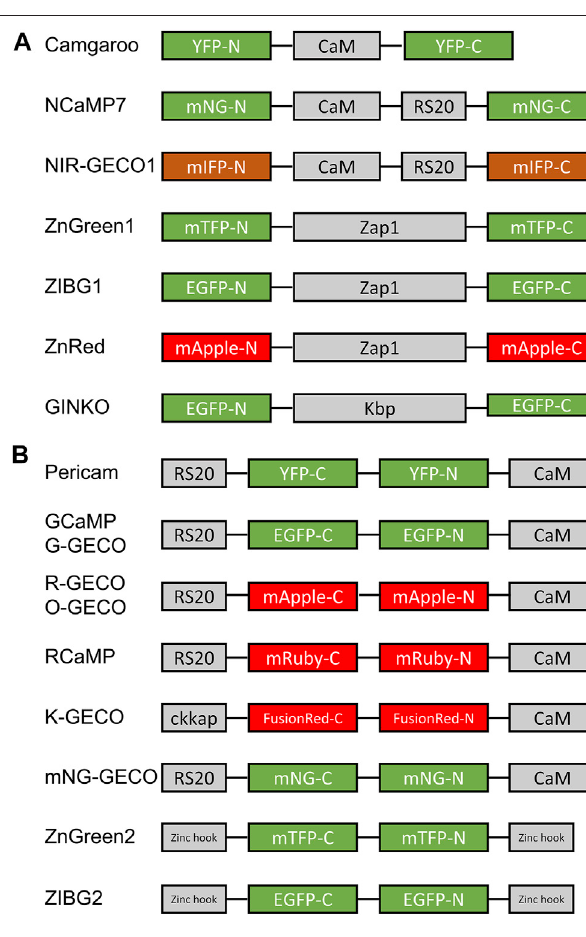
FIGURE 3 | Schematic illustrations of representative cp and ncp FP- based indicators. (A) An ncp FP-based indicator is constructed by inserting a binding domain into an FP. Examples of ncp FP-based indicators include camgaroo (Baird et al., 1999), NCaMP7 (Subach et al., 2020), NIR- GECO1(Qianetal.,2019),ZnGreen1(ChenandAi,2016),ZIBG1(Chenetal., 2019), ZnRed (Chen and Ai, 2016), and GINKO (Shen et al., 2019). (B) A cp FP-based indicator is constructed by inserting a cp FP into a binding domain or by fusing two interacting motifs to the termini of the cp FP. The cpFP indicators include pericam (Nagai et al., 2001), GCaMP (Chen et al., 2013; Dana et al., 2019), G-GECO (Zhao et al., 2011), R-GECO (Zhao et al., 2011), O-GECO (Wu et al., 2013), RCaMP (Akerboom et al., 2013), K-GECO (Zhao et al., 2011), mNG-GECO (Zarowny et al., 2020), ZnGreen2 (Chen and Ai, 2016), and ZIBG2 (Chen et al.,